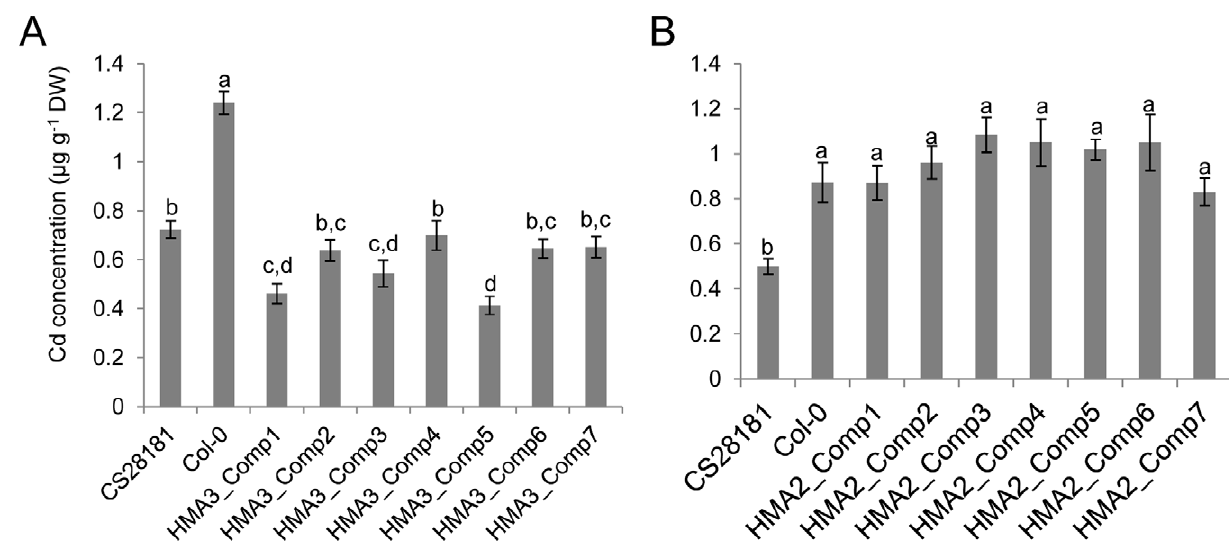
Figure 4. Transgenic complementation of the high leaf Cd phenotype of A.thaliana Col-0. The A. thaliana Col-0 accession was transformed with either CS28181 HMA3 (A) or HMA2 (B) and leaf Cd concentration determined. Transgenic complementation lines were made by introducing the CS28181 genomic DNA fragments of HMA3 and HMA2 (including promoter sequences) into the Col-0 accession. Data represents the mean leaf Cd concentration 6 standard errors (n=6–12 independent plants per genotype). Letters above bars indicate statistically different groups using a one- way ANOVA with groupings by Tukey’s HSD using a 95% confidence interval.